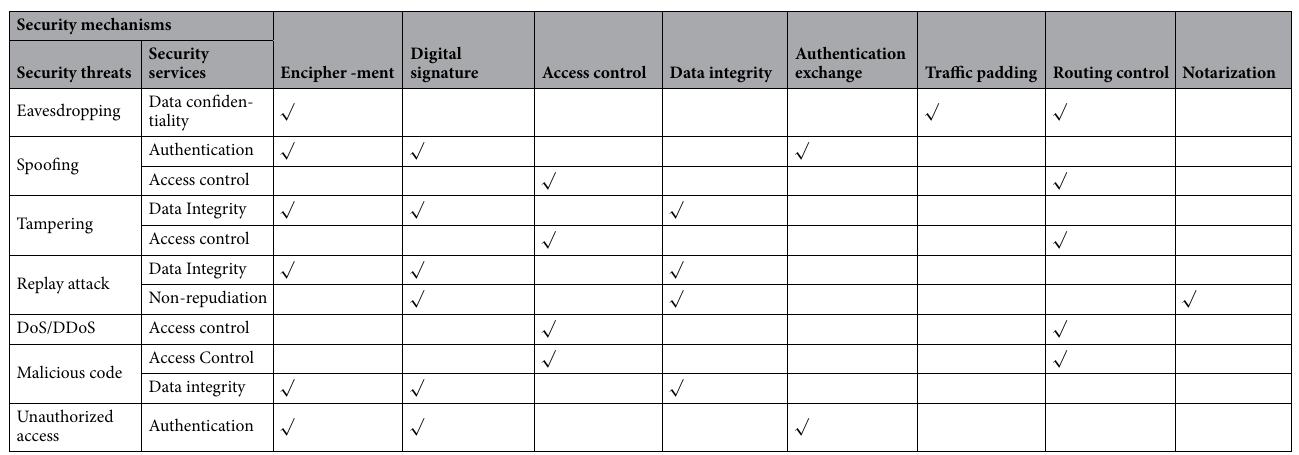
Table 2. The main security threats of SINs and the related security services and security mechanisms